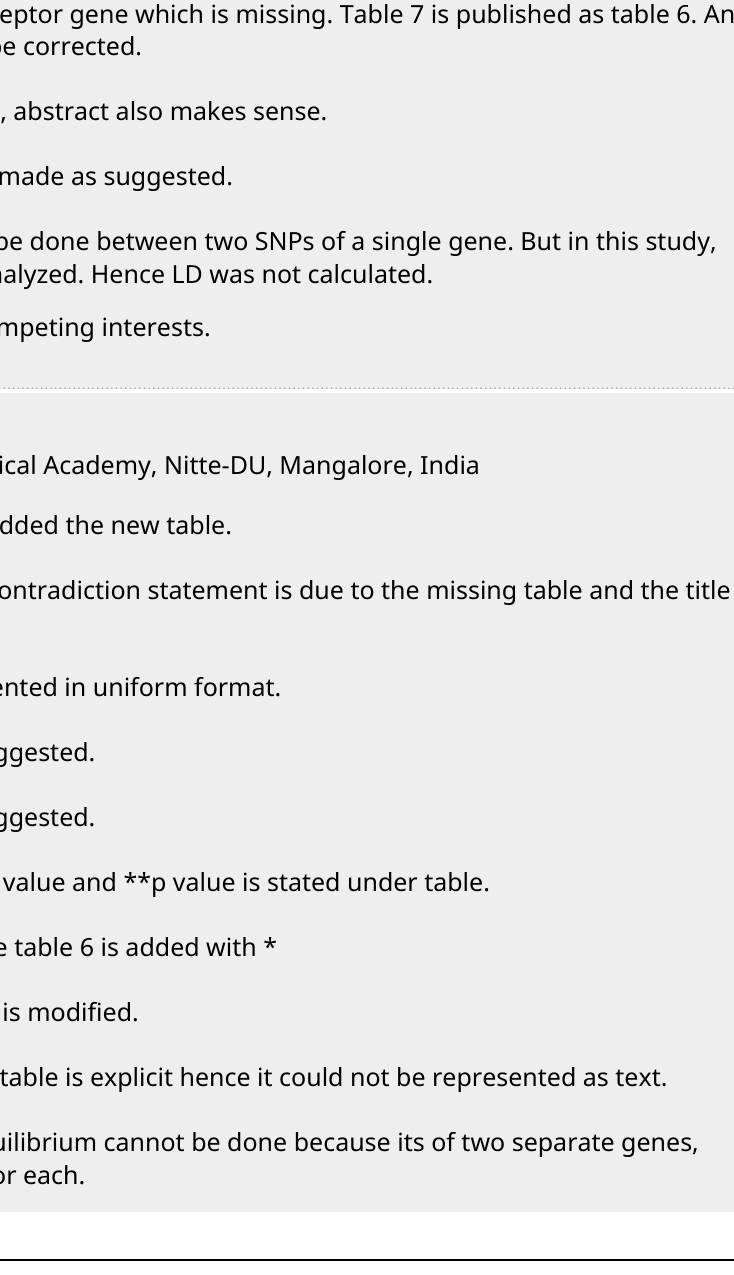
Table 6 represents the comparison of biochemical parameters of leptin gene and Table 7 represents that of leptin receptor gene which is missing. Table 7 is published as table 6. And table 6 is missing. This will be